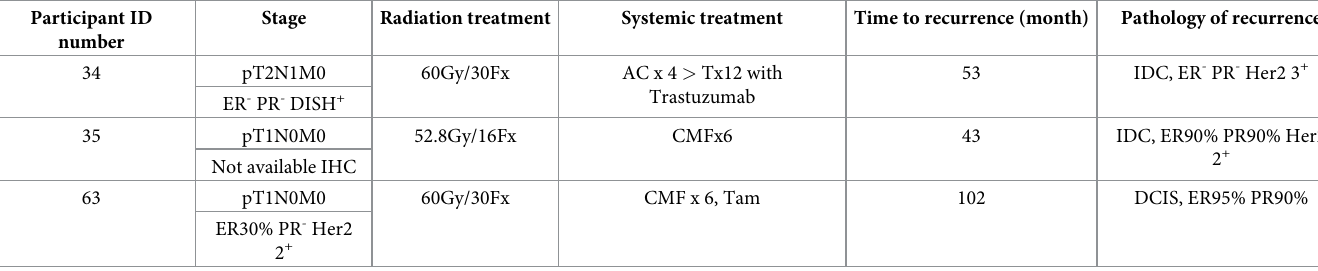
Table 2. Characteristics of the three participants who developed ipsilateral local